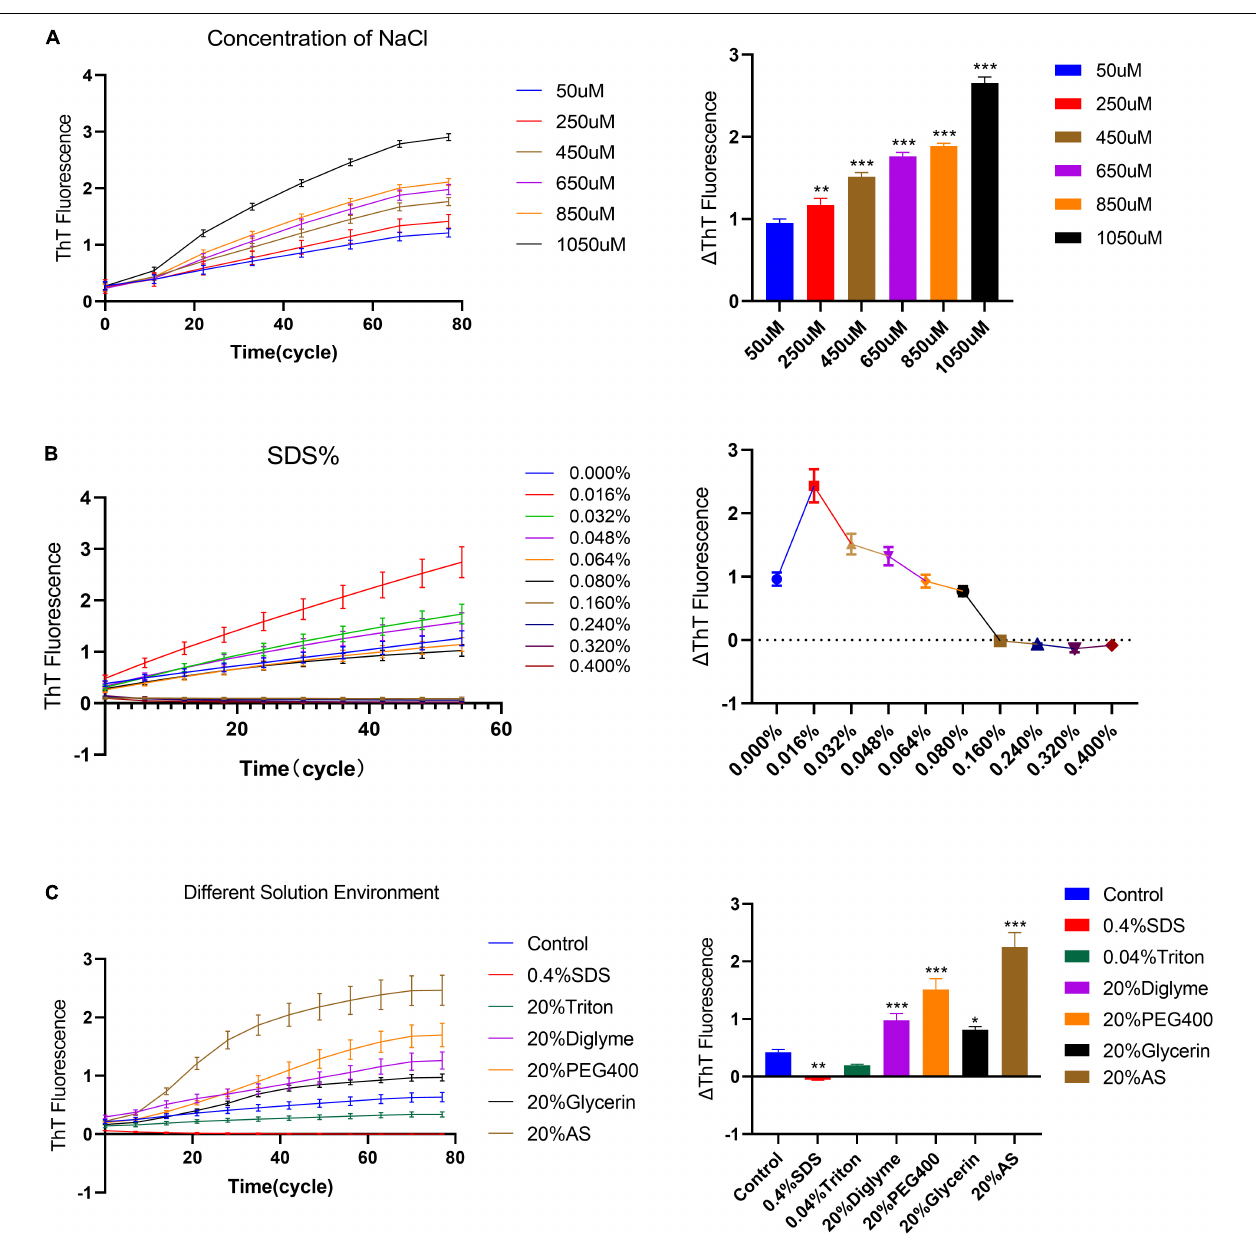
FIGURE 4 | The effect of different solution environments on the seed quiescent incubation curve. (A) Quiescent incubation curve under different concentrations of NaCl, left. Corresponding (cid:49) ThT fluorescence value, right. (cid:49) ThT increases with increasing concentration of NaCl. Compared with the 50 µ M NaCl group, ** P < 0.01, *** P < 0.001. (B) Quiescent incubation curve under different concentrations of SDS%, left. Corresponding (cid:49) ThT fluorescence change value, right. With a lower concentration of SDS ( < 0.064%), the (cid:49) ThT was significantly increased. With a higher concentration of SDS ( > 0.064%), the (cid:49) ThT was significantly decreased. (C) The effects of various solution environments on the seed quiescent incubation curve, including 0.4% SDS, 0.04% Triton -X100, 20% Diglyme, 20% PEG400, 20% Glycerol, and 20% Ammonium sulfate, left. Corresponding (cid:49) ThT fluorescence change value, right. Compared with the control group, * P < 0.05, ** P < 0.01, *** P < 0.001. All data are expressed in mean ±